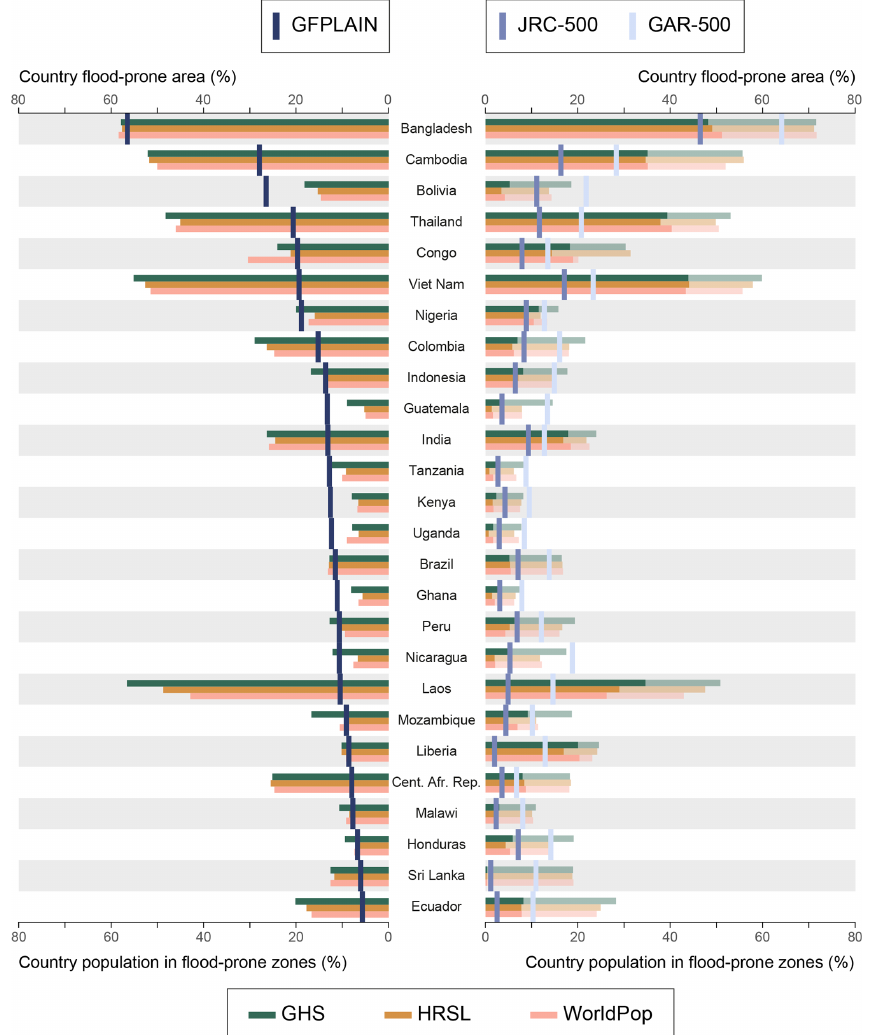
Figure 7. Riverine flood exposure estimates, aggregated at country level, using the hydrogeomorphic floodplain map GFPLAIN (bars on the left) and the flood hazard maps of the JRC (bars on the right) and GAR (shaded bars on the right) with a 500-year return period. The green, orange, and pink horizontal bars indicate the percentage of the country’s population in flood-prone zones using the population maps Global Human Settlement population grid, High Resolution Settlement Layer, and WorldPop, respectively. The vertical blue bars indicate the percentage of land area that is flood-prone. Country boundaries follow the GAUL 2015 dataset, and permanent water has been masked by the product